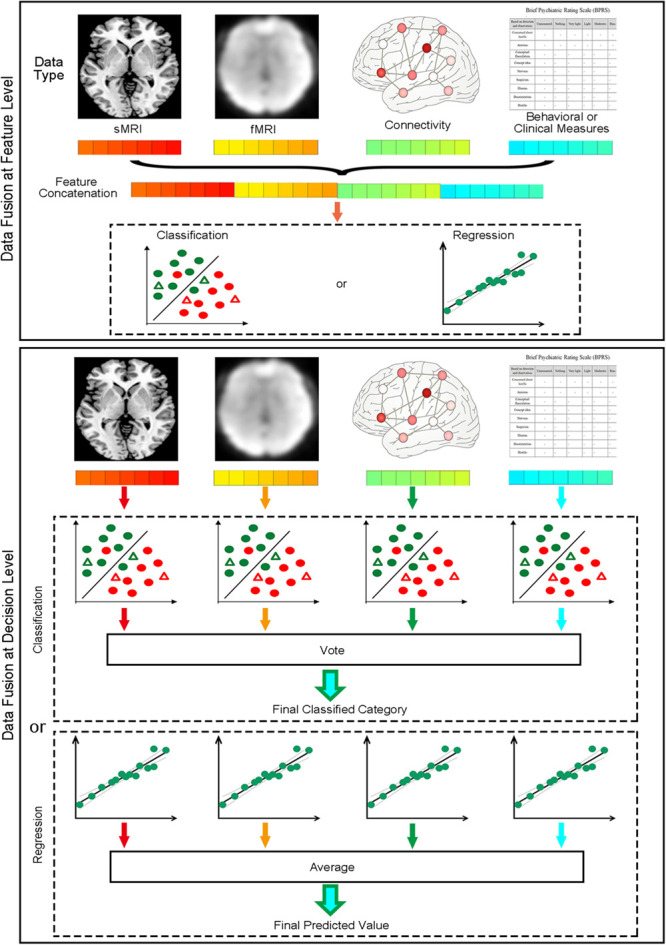
Two data fusion strategies implemented in MVPANI. The upper panel shows the feature concatenation strategy, where data are fused at the feature level by concatenating all different types of features into a single feature vector before feeding them into a classification or regression model. The lower panel shows the voting strategy, where data are fused at the decision level by building a classification or regression model for each type of data and then all models vote for the final decision (for classification, taking the majority of all models’ decisions; for regression, averaging the predicated values of all models).